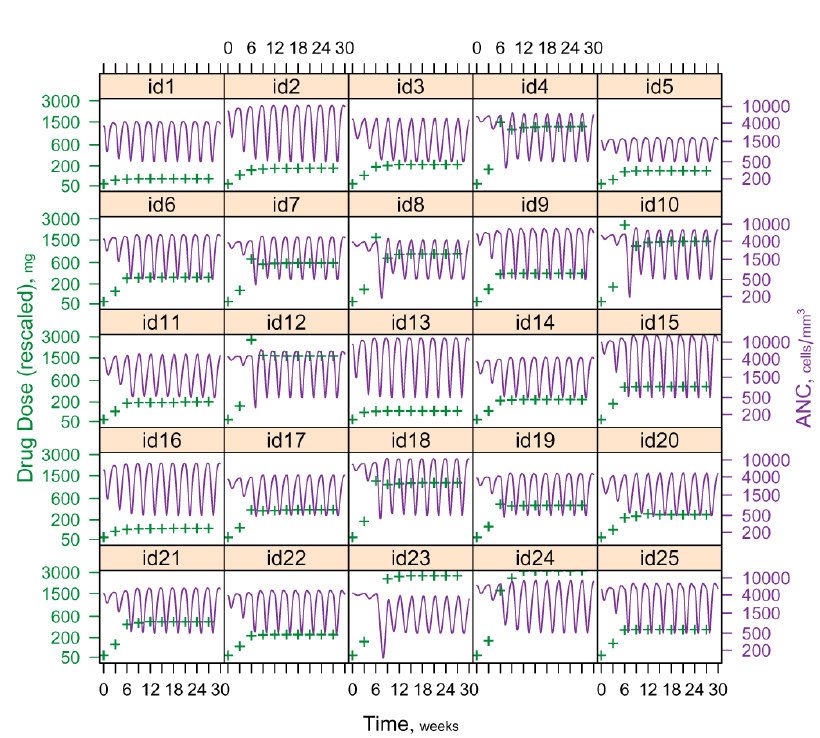
Figure 5. Titration profiles in 25 simulated patients over ten 3-week cycles of chemotherapy. Note particularly the overshooting that occurs in subjects id8 , id10 , id12 and id23 . This underscores the importance, in actual DTAT applications, of imposing fail-safe upper bounds both on absolute dose and on relative dose increases . It also bears noting that the 25 MTD of